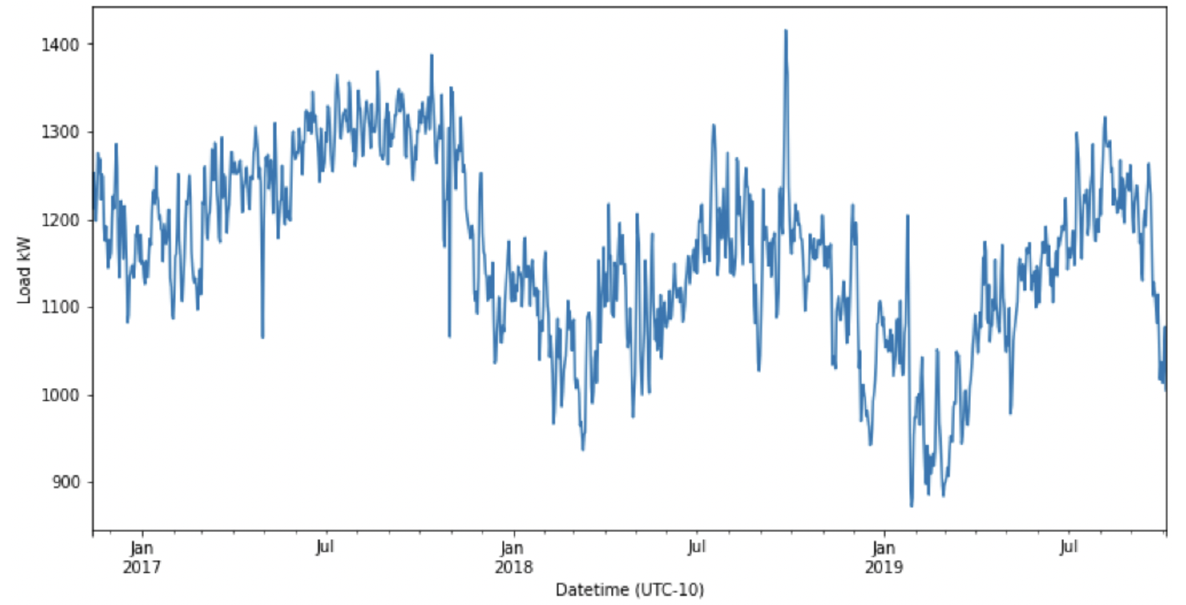
Figure 6. Hotel 1 load cleaned of outliers and resampled (for viewing) with a daily average, a strong seasonality and slight decreasing trend can be